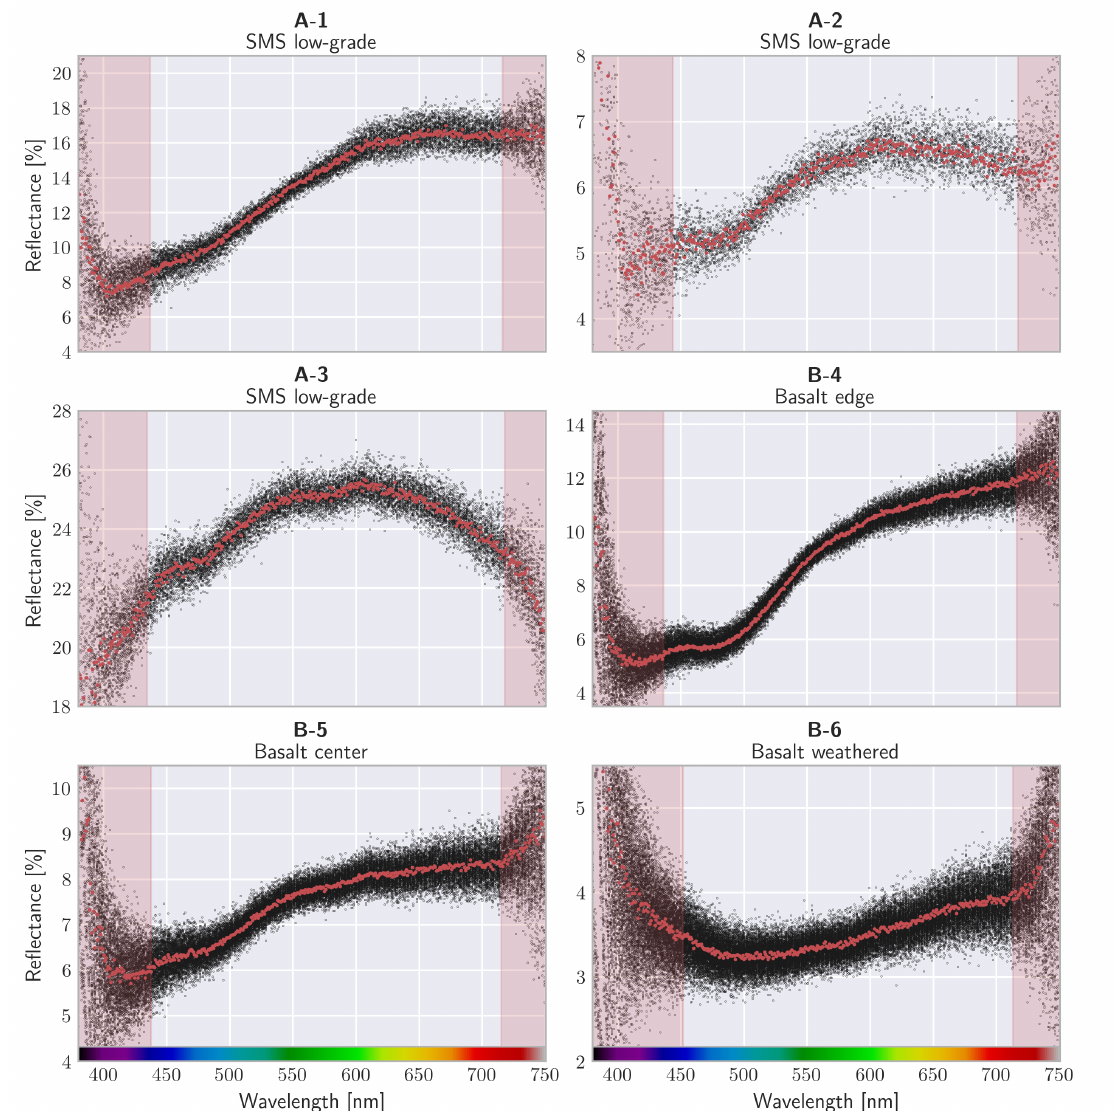
Figure 7. Calculated reflectance from the marked areas. The red points are the medians across wavelengths, and the points in black are calculated reflectances for individual pixels centred on the median. The regions in red are regions where the signal-to-noise ratio was below the